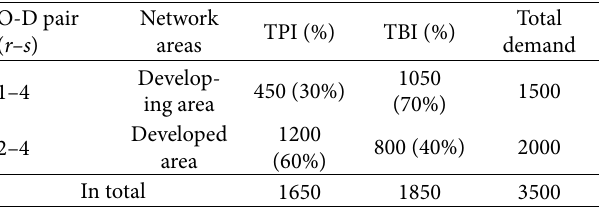
Table 7: Proportion of TBI and TPI in traffic demand in this